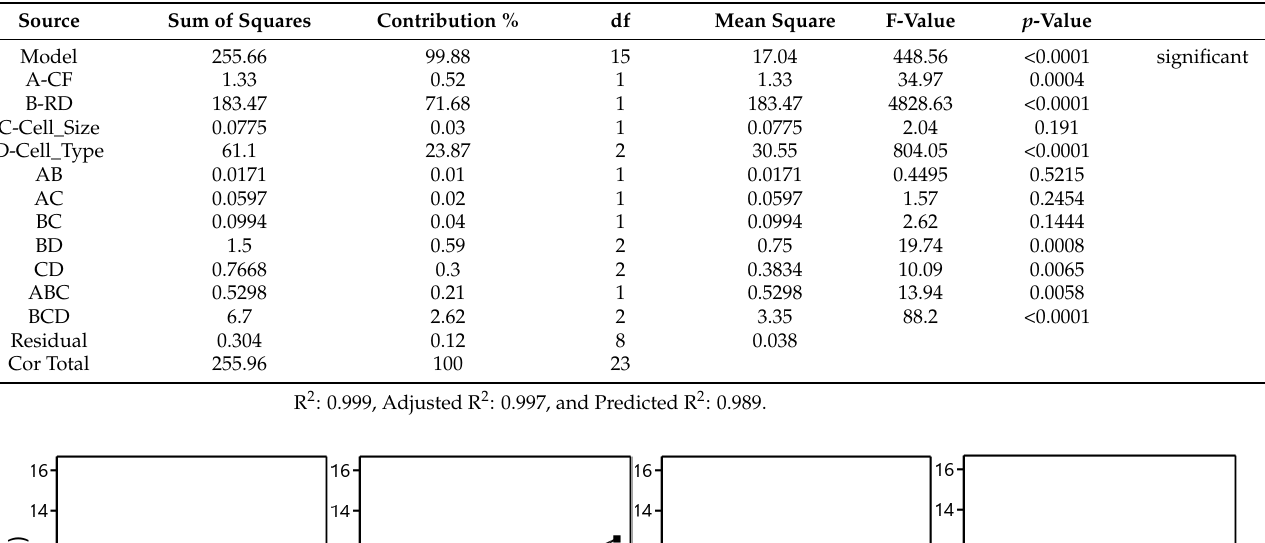
Table 6. Reduced ANOVA Table of σ peak .